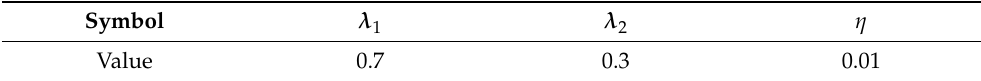
Table 4. Specific upper controller